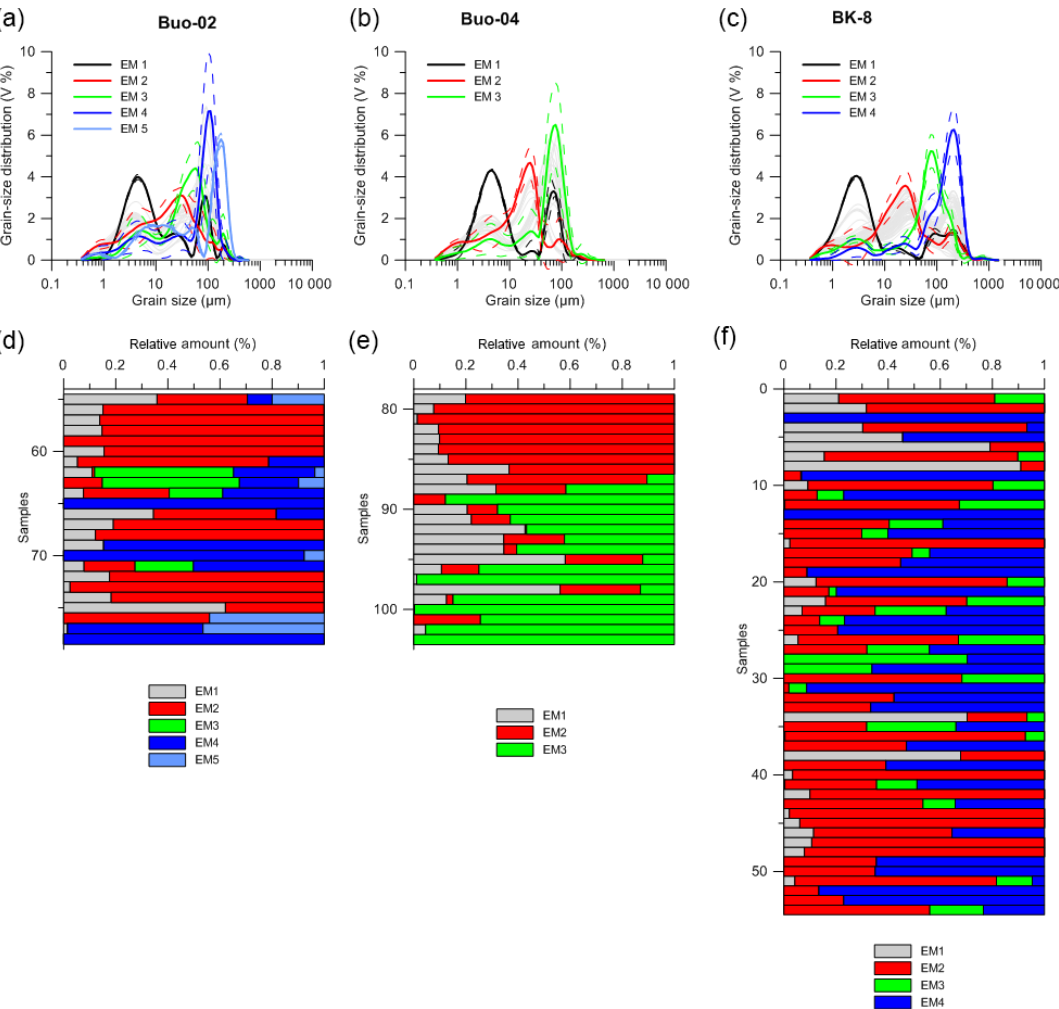
Figure 14. Results of the end-member analysis of the studied Buo-02, Buo-04, and BK-8 sequences; (a, b, c) results of robust end-member modelling (grey curves in the background represent the original grain-size distributions of each sample; dashed lines mark the standard deviation for each end-member); (d, e, f) distribution of robust end-member loadings for each sample (note: due to better visibility loadings are not plotted with depth but in the same